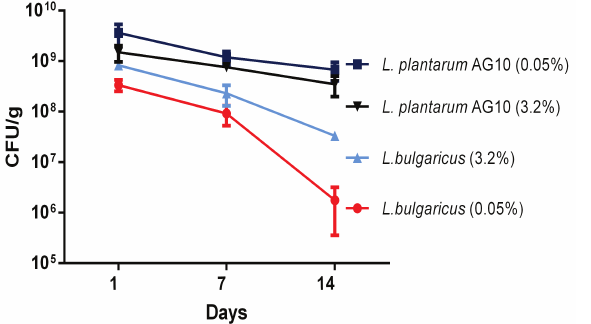
Figure 7. Amount of viable LAB in skimmed and whole milk fermented with either L. bulgaricus or L. plantarum AG10 measured by direct CFUs count after 1, 7, and 14 days of storage. The % of initial fat in the milk is shown.